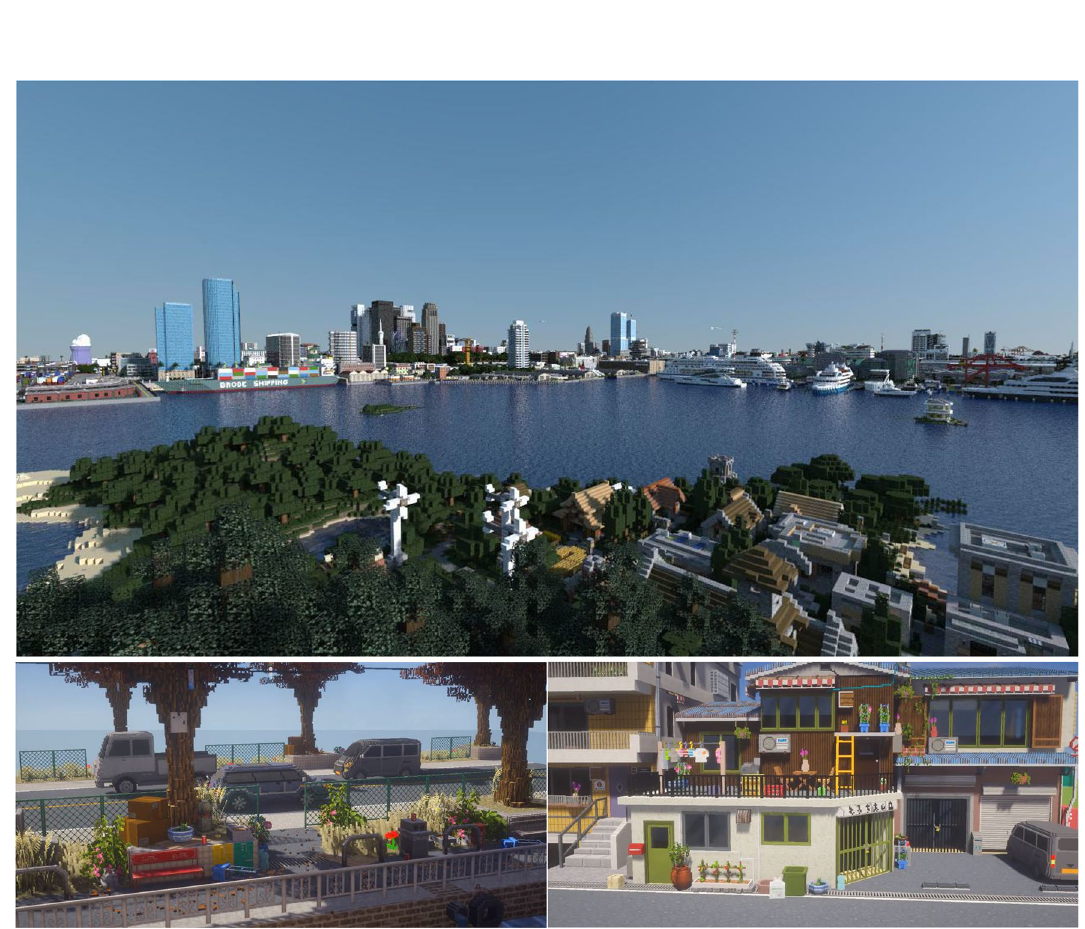
Figure 3. Virtual world constructed in MineCraft . Up: The open virtual world AudiaCity that we used to build our dataset. Down: Users can achieve higher resolution scenes or buildings by applying plugins that adjust the blocks to small